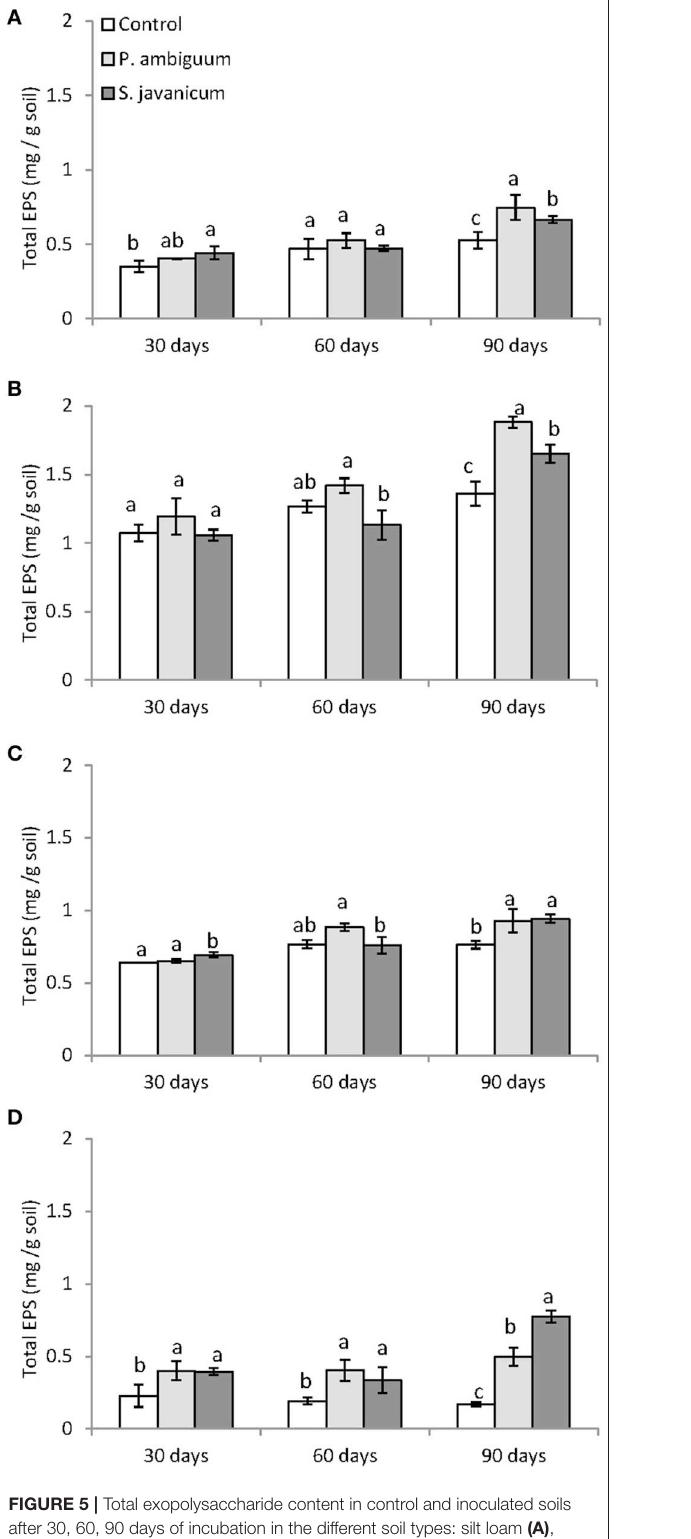
FIGURE 5 | Total exopolysaccharide content in control and inoculated soils after 30, 60, 90 days of incubation in the different soil types: silt loam (A) , sandy loam (B) , loamy sand (C) , and sandy (D) . Different letters indicate significant differences among cyanobacteria